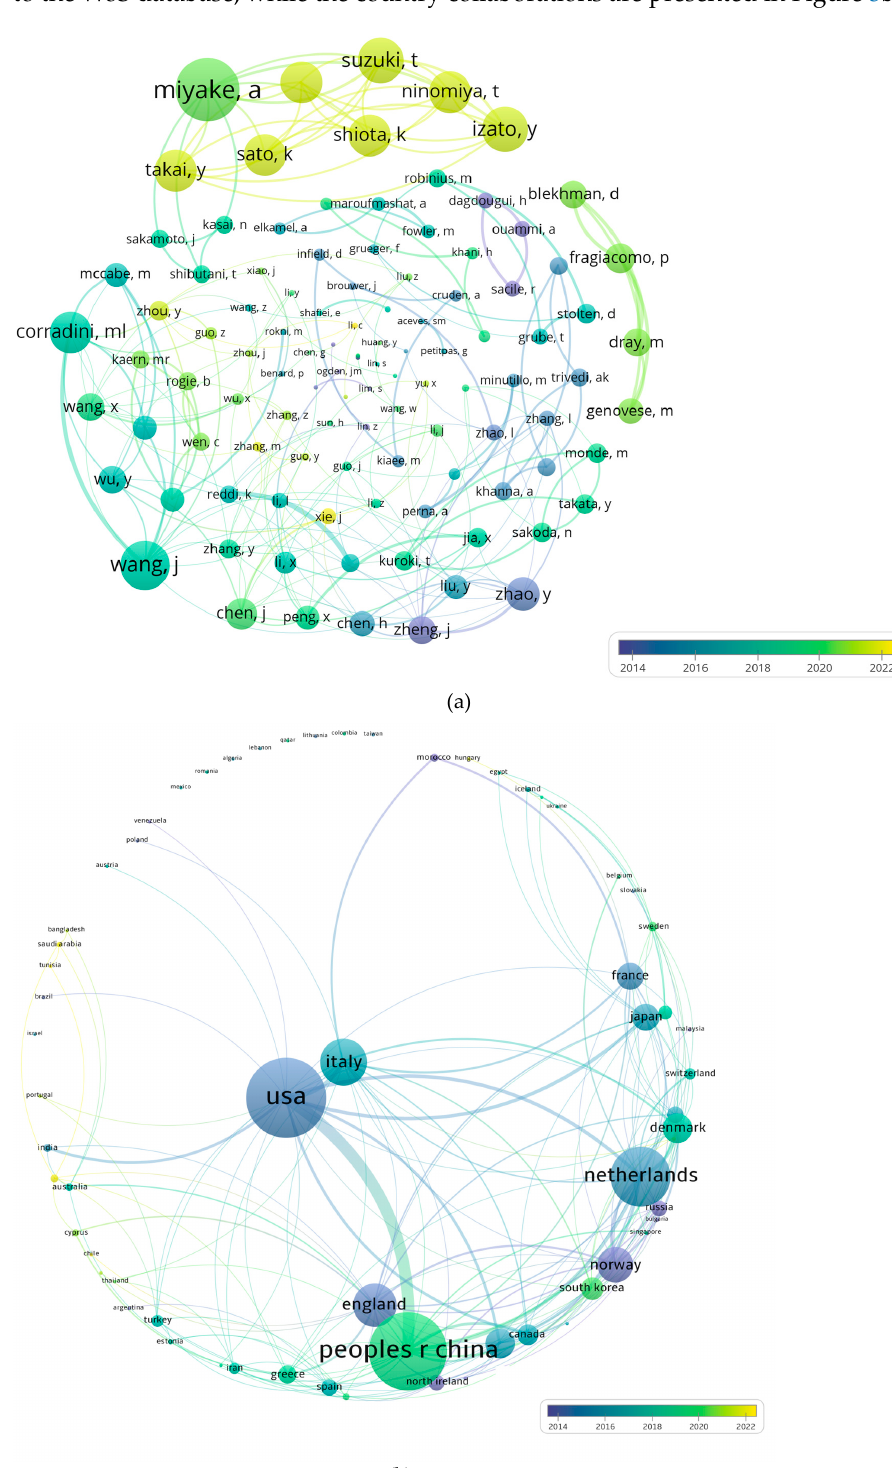
Figure 3. Clusters of authors according to VoSviewer ( a ) and Countries’ collaborations ( b ), by processing WOS